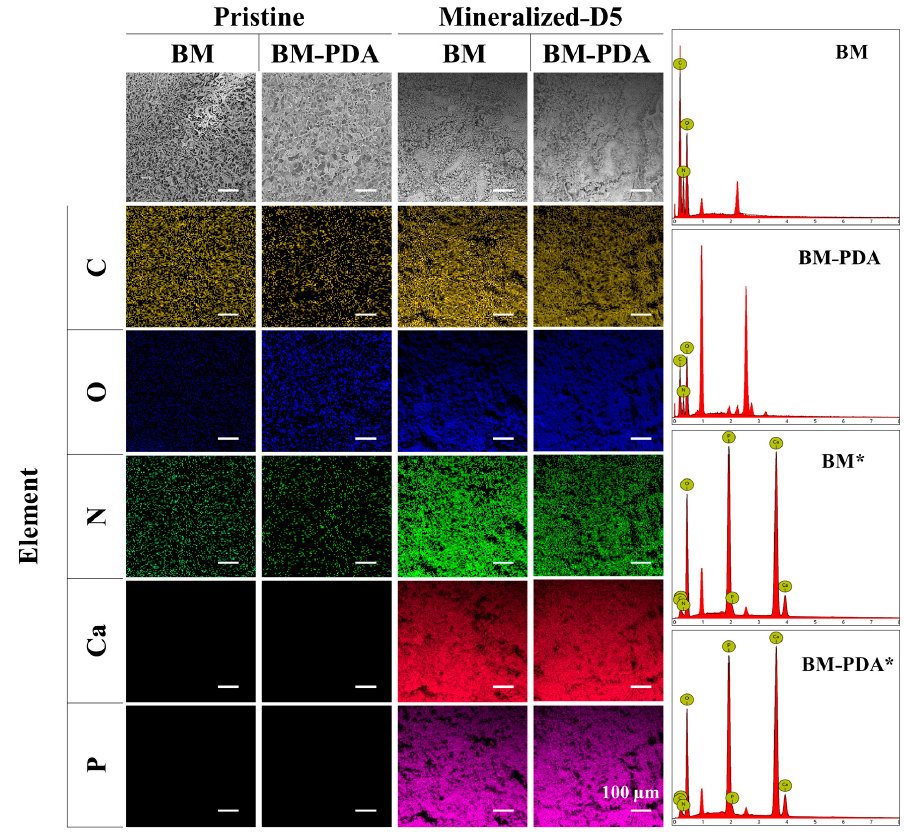
Figure 4. EDX plotting images of C, O, N, P, and Ca of BM, BM ˗ PDA, BM*, and BM ˗ PDA*. Scale bar = 100 μ m.